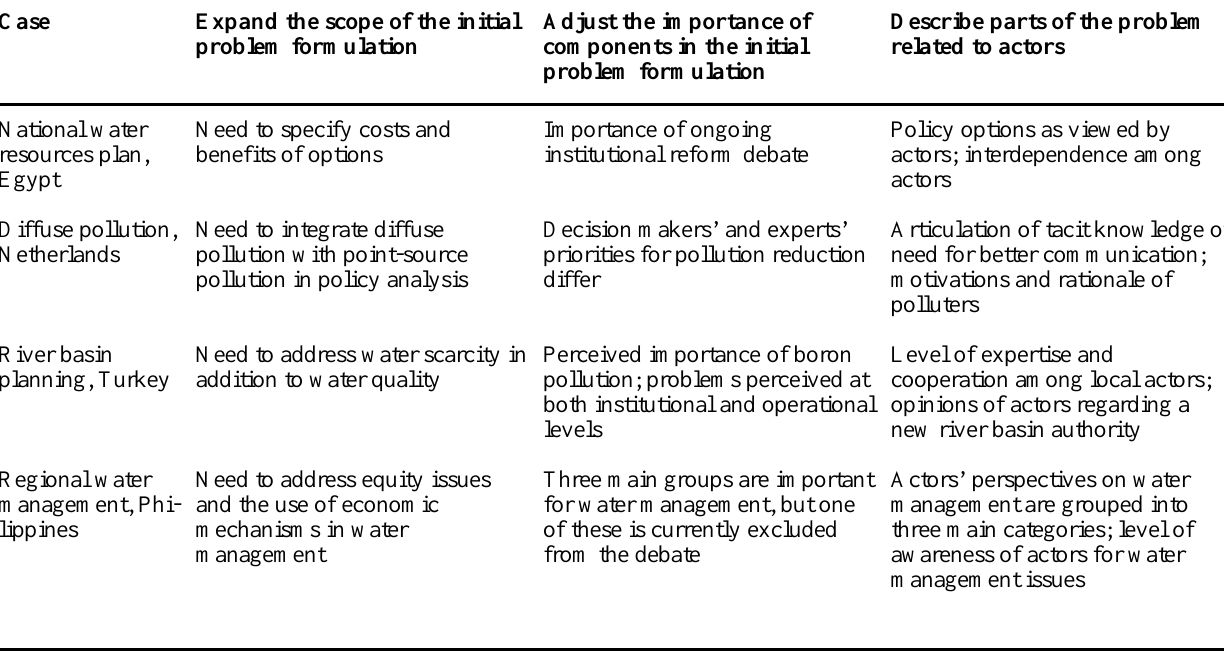
Table 2. Actor analysis output that had implications for substantive problem